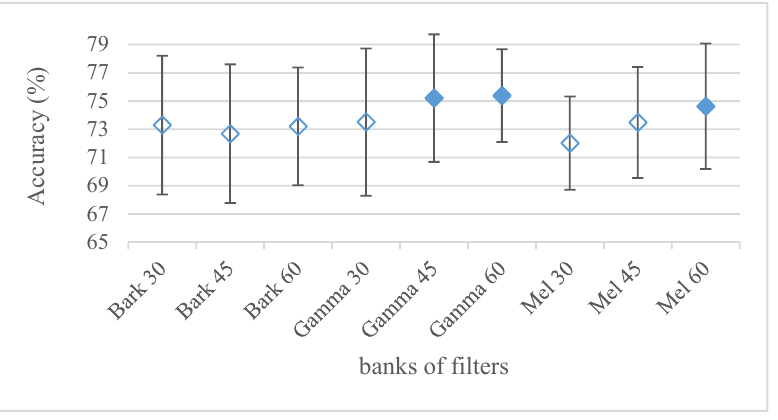
Figure 12. Averaged accuracies and standard deviations for Mel, Bark, and Gammatone FBs, hav- ing 30, 45, and 60 bands with an 8 kHz maximal frequency. Filled marks show equally performing settings.